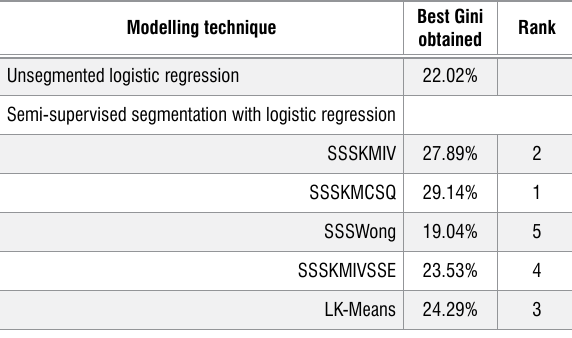
Direct marketing data set: comparison of performance of techniques